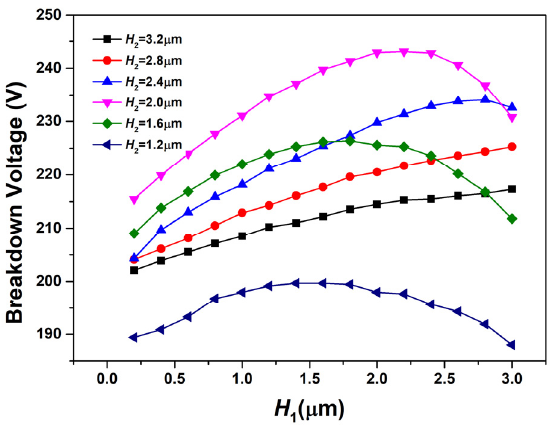
Figure 8. Dependence of the BV on the length of floating electrodes ( H 1 ) at different depth (H 2 ) for the DFSGRSO UMOSFET.